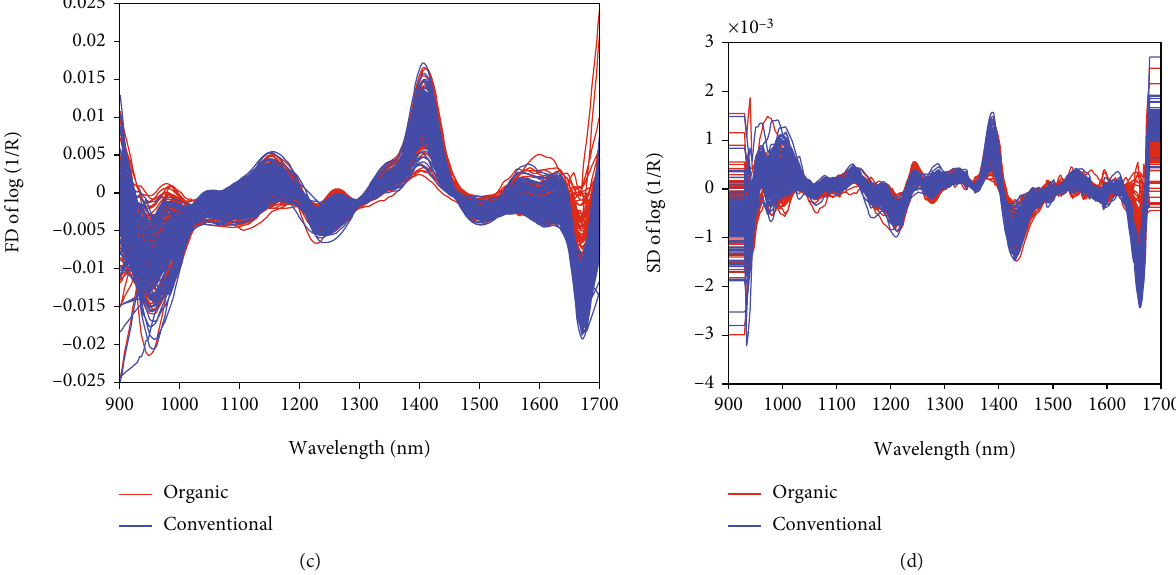
Figure 1: Spectra: (a) raw spectra, (b) mean centering, (c) fi rst derivative, and (d) second derivative of cocoa bean